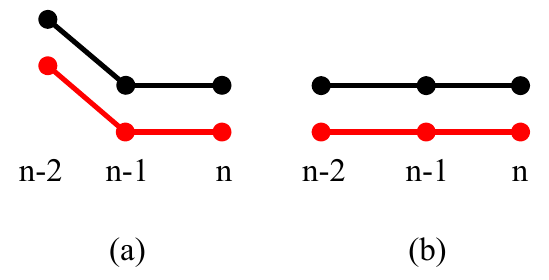
Figure 6 . T ( n − 1) = 00 and T ( n ) = 00. ( a ) An vehicle has been detected to be in the measuring range of the sensor system before; ( b ) No vehicle has been detected in the sensor's measuring scope before.